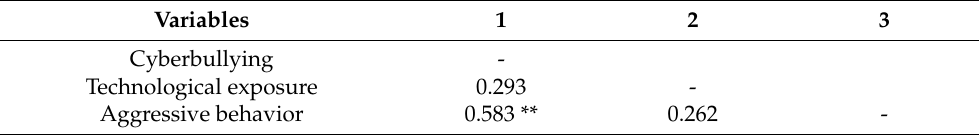
Table 4. Correlation analysis. Variables 1 2 3 Cyberbullying - Technological exposure 0.293 -